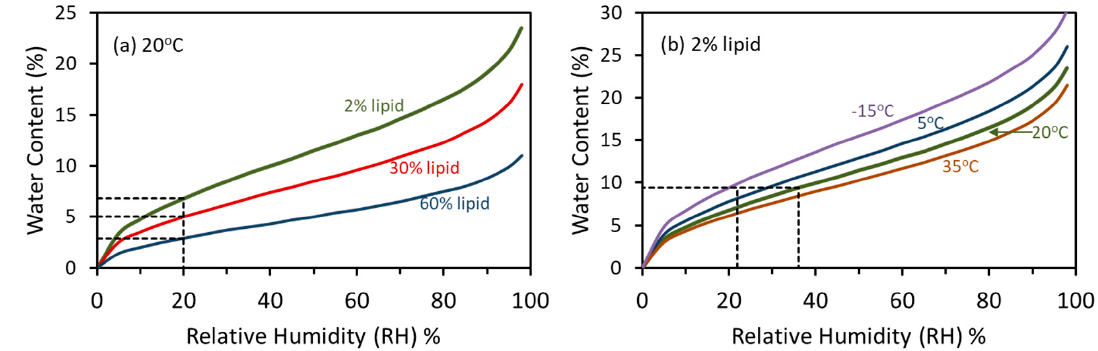
Figure 4. Water sorption isotherms describe the relationship between water content and RH in materials, including seeds. These isotherms were calculated from the Seed Information Database module [80] for seeds at 20 ◦ C and different lipid contents ( a ) and for a seed containing 2% lipid ( b ) at different temperatures. In ( a ), the dashed lines represent water contents associated with 20% RH for seeds containing 2% (e.g., pea), 30% (e.g., lettuce) and 60% (e.g., peanut) lipid: 6.8%, 5.0%, 2.9% water, respectively. In ( b ), dashed lines show the drying conditions needed to meet FAO (2014) standards [14]. That is, storing a seed containing 2% lipid at 20% RH and − 15 ◦ C requires adjusting the water content to 9.4% water, which can be done by drying it at 20 ◦ C and 36% RH. As the term ‘isotherm’ implies, temperature affects the amount of water that adsorbs onto molecules, with water content decreasing with increasing temperatures (Figure